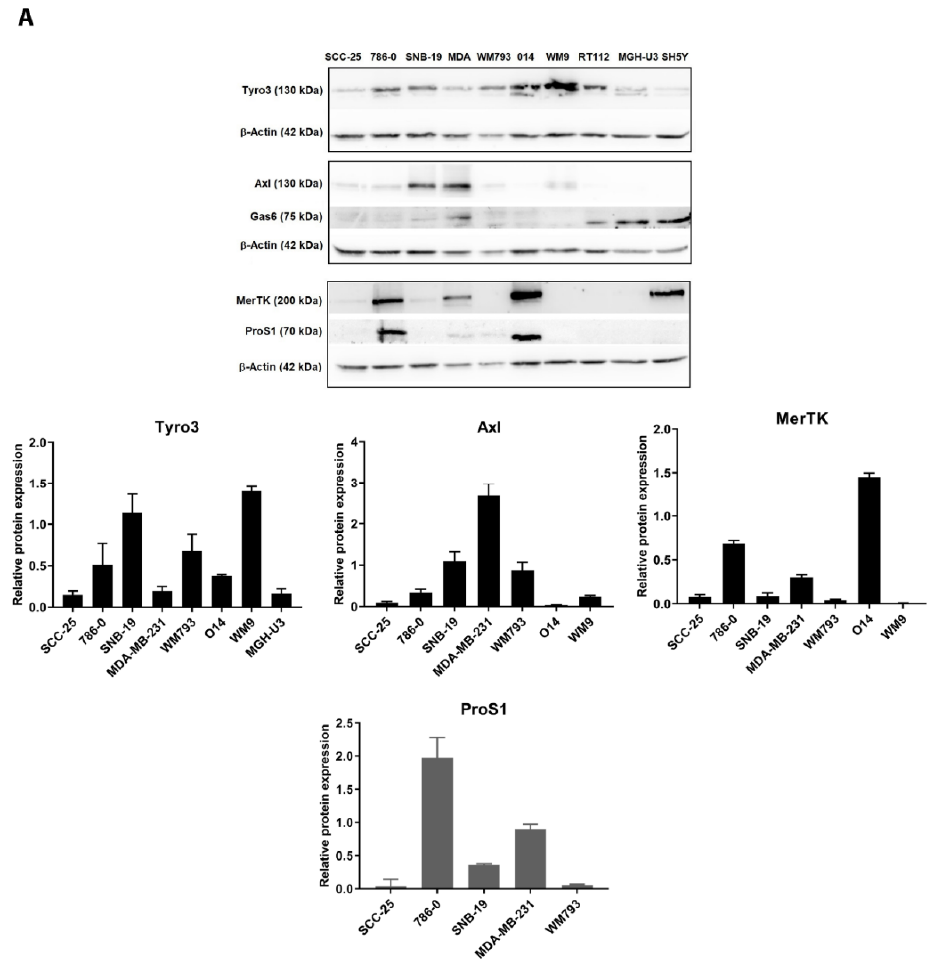
Figure 1. Cont . Figure 1.